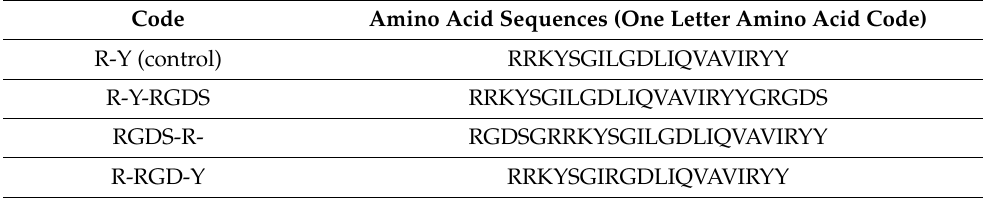
Table 1. Peptide sequence of designed